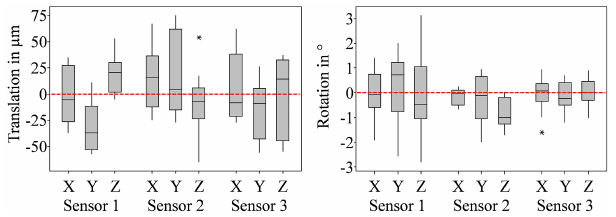
Figure 10. Ranges of data sets’ translations and rotations done by a manually coarse registration (boxplots) in comparison to best-fit fine registration (pointed